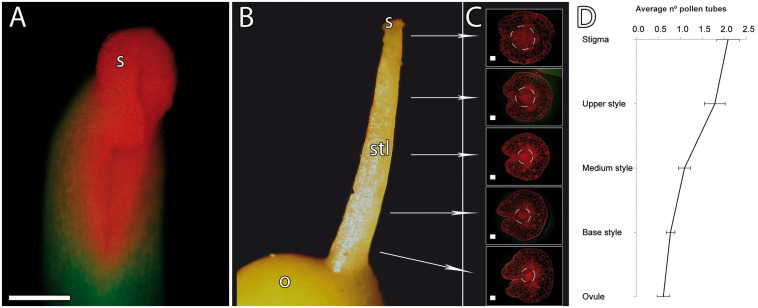
Pistil anatomy and pollen tube numbers along the pistil in mango. (A) Stigma and style stained with acridine orange. The stigma shows a horseshoe-shaped morphology stained in orange. (B) Pistil anatomy. (C) Gradual reduction of the transmitting tissue of the style (as shown with acridine orange staining of 2-μm transverse resin sections). (D) Gradual reduction of the number of pollen tubes along the stigma, style, and ovule (n = 99). Error bars indicate standard errors. Data were collected from 24 pistils. S, stigma; STL, style; O, ovary. (A) Scale bar, 100 μm. (C) Scale bars, 20 μm.